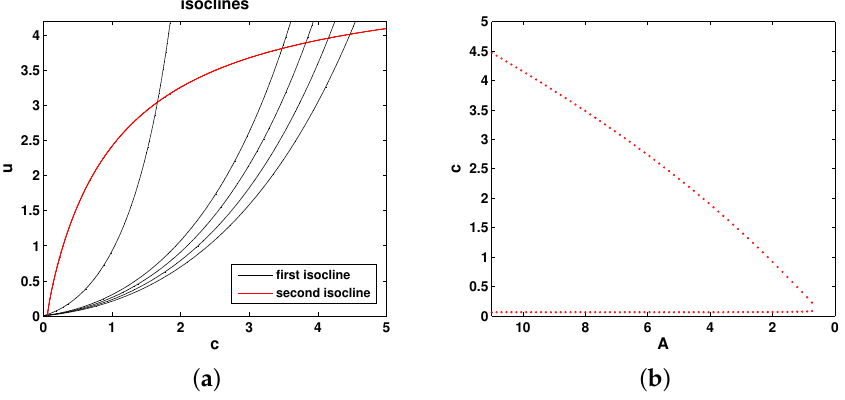
Figure 6. ( a ) The (null-)isoclines of the oxygen-phytoplankton system for Model 5. Black curves show the oxygen isocline ( u I ) for A = 3.5,8,9,10 and 11 (from left to right, respectively), and the red curve shows the phytoplankton isocline ( c II ). ( b ) Positive steady states of Equations (17) and (18) shown as functions of A . Here, c 2 = 0.5, other parameters are the same as in Figure 4.